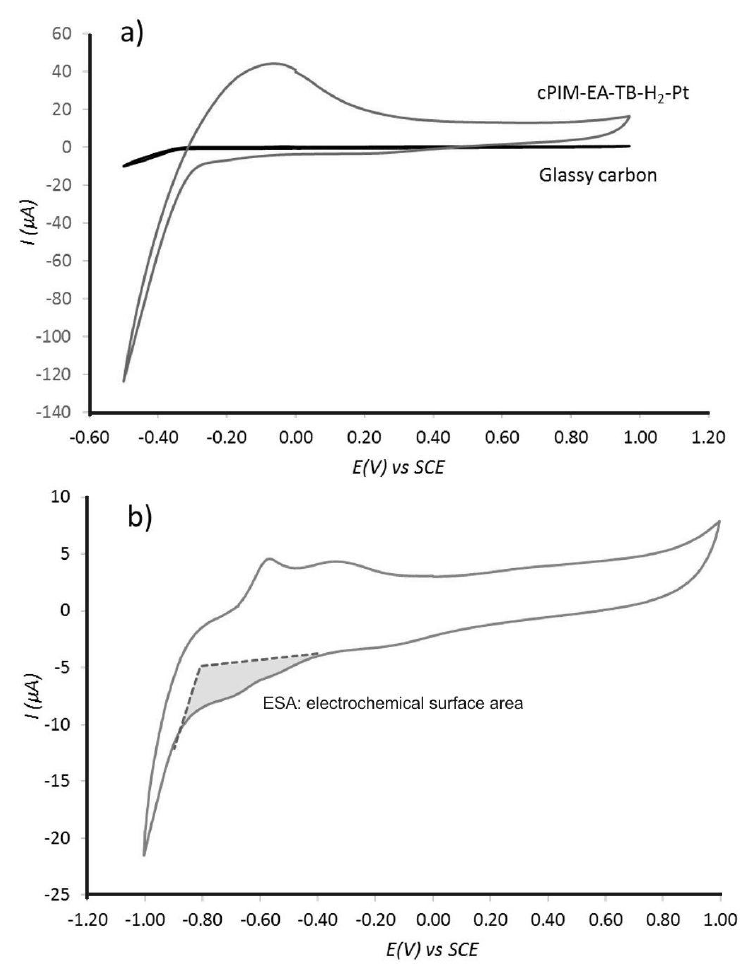
Figure 4. Cyclic voltammograms (3rd cycle, Ar saturated, scan rate 10 mV s −1 ) at Pt@cPIM immobilized onto a 3 mm diameter glassy carbon electrode immersed into ( a ) 0.1 M HClO 4 solution and ( b ) 10 mM phosphate buffer pH 7 solution with highlighted hydrogen electrochemical underpotential adsorption region (grey).